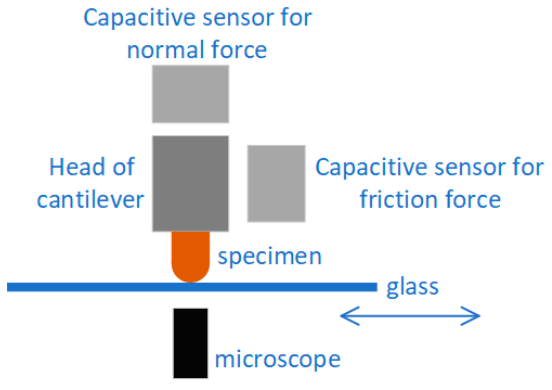
Figure 2. Sketch of the optical in situ microtribometer.